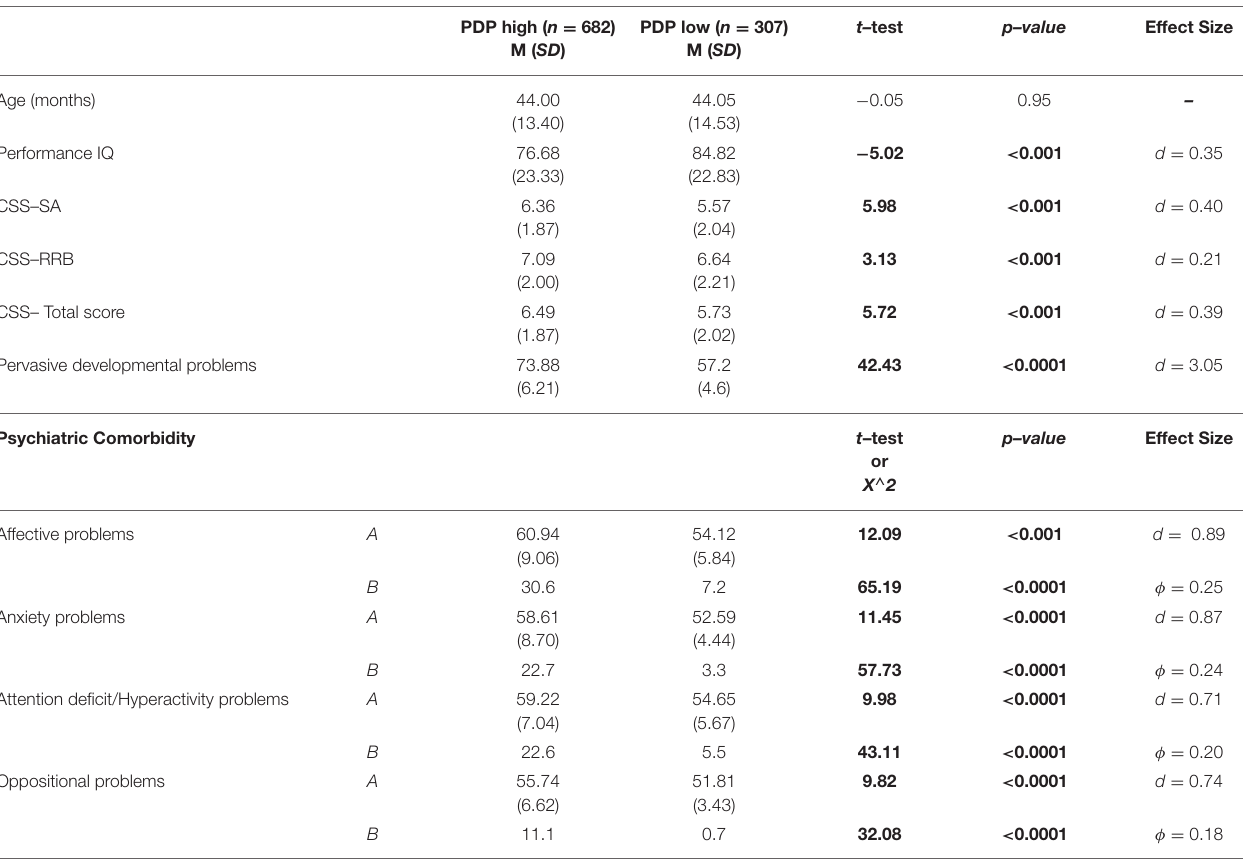
TABLE 5 | Clinical comparison of ASD subjects with high scores on CBCL–PDP scale and subjects with low score on CBCL–PDP